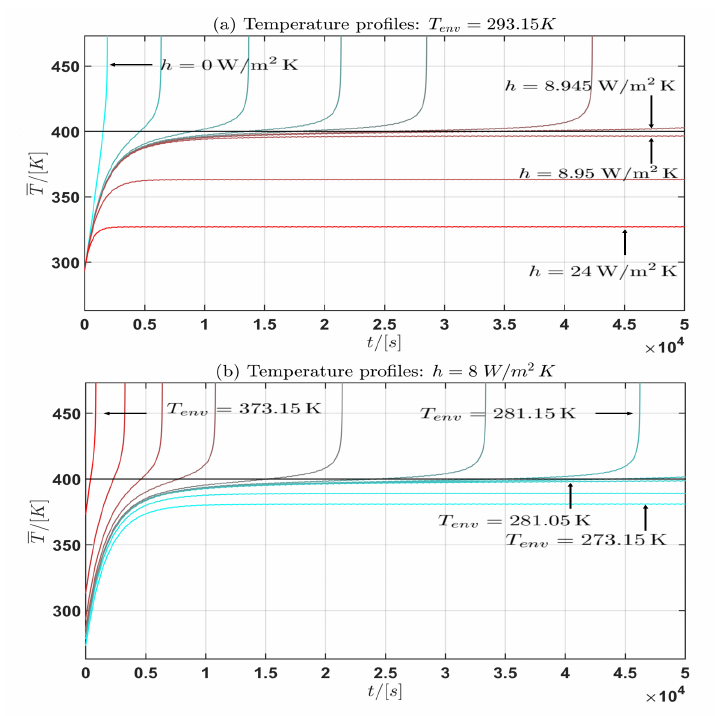
Figure 6. Profile (I) : Temperature profile for the mean cell temperature T : ( a ) T env fixed, h varied; ( b ) h fixed, T env varied.